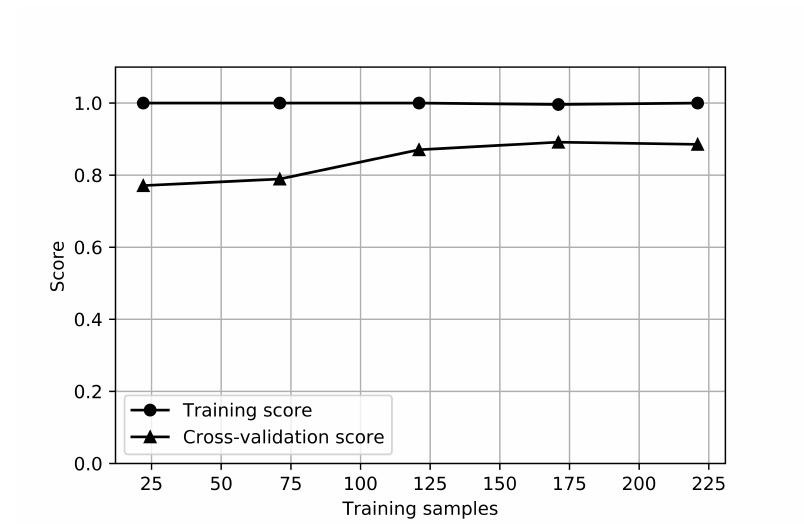
Figure 4. Learning curves of depression classifier.